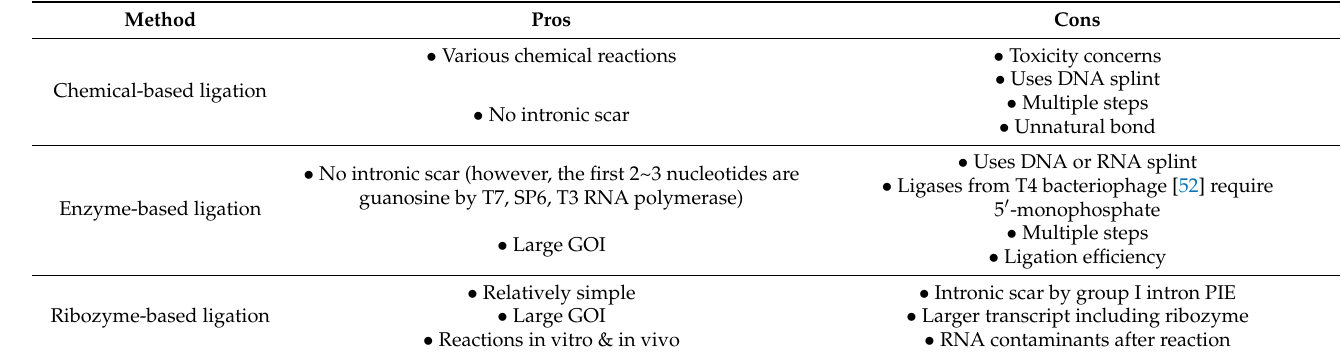
Table 1. Pros and cons of each circRNA preparation method for practical